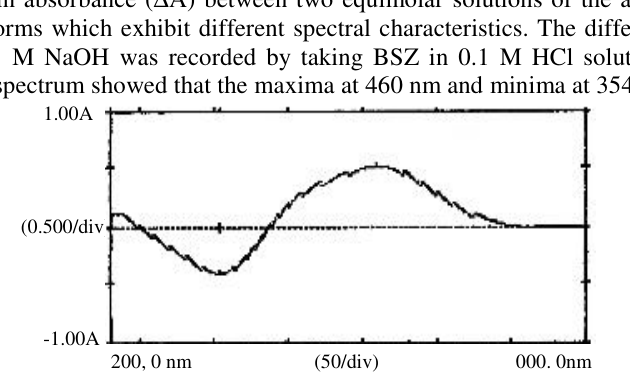
Figure 1. Difference spectrum of BSZ (10 µ g/mL solution of BSZ in 0.1 M HCl was taken as blank and the same concentration of drug in 0.1 M NaOH as